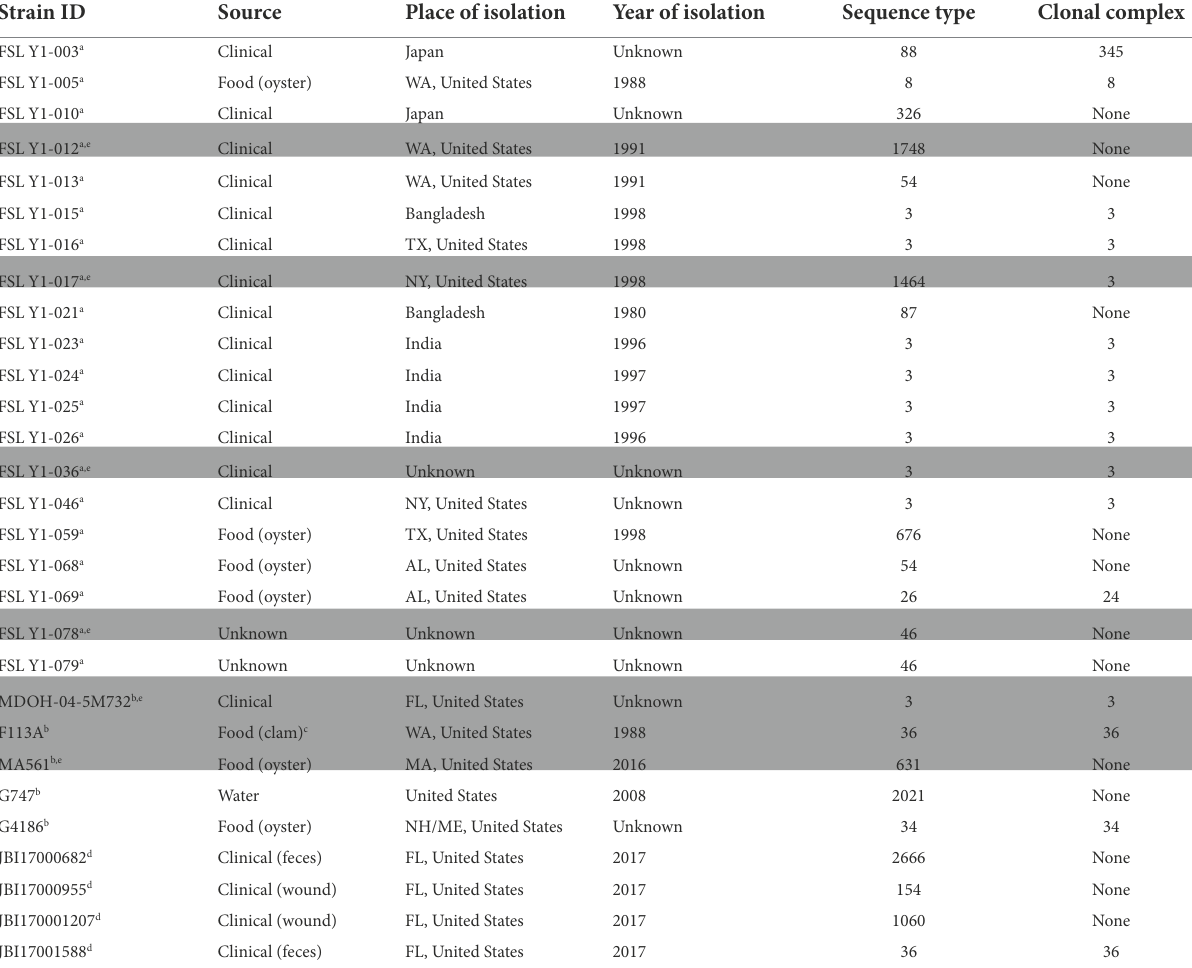
TABLE 1 Vibrio parahaemolyticus isolates used in this study. Strain